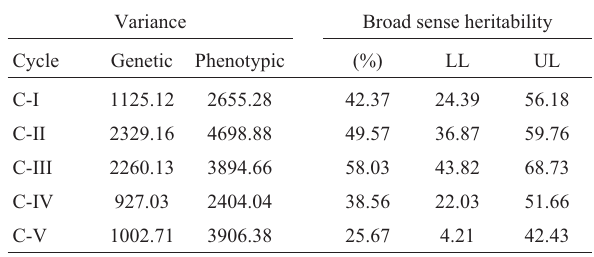
Table 2 - Genetic variance ( (cid:2) σ Table 4 - Genetic variance ( (cid:2) σ 2 ) and phenotypic variance ( (cid:2) σ 2 ) estimates 2 ) and phenotypic variance ( (cid:2) σ 2 ) estimates G F G F between means of progenies and broad-sense heritability ( h 2 ) with its re- between means of progenies and broad-sense heritability ( h 2 ) with its re- spective lower (LL) and upper (UL) limit of the S 0:1 generation in the first spective lower (LL) and upper (UL) limit of the S 0:1 generation in the first to fifth recurrent selection cycle for the angular-leaf-spot disease severity to fifth recurrent selection cycle for grain yield in g m -2 score.